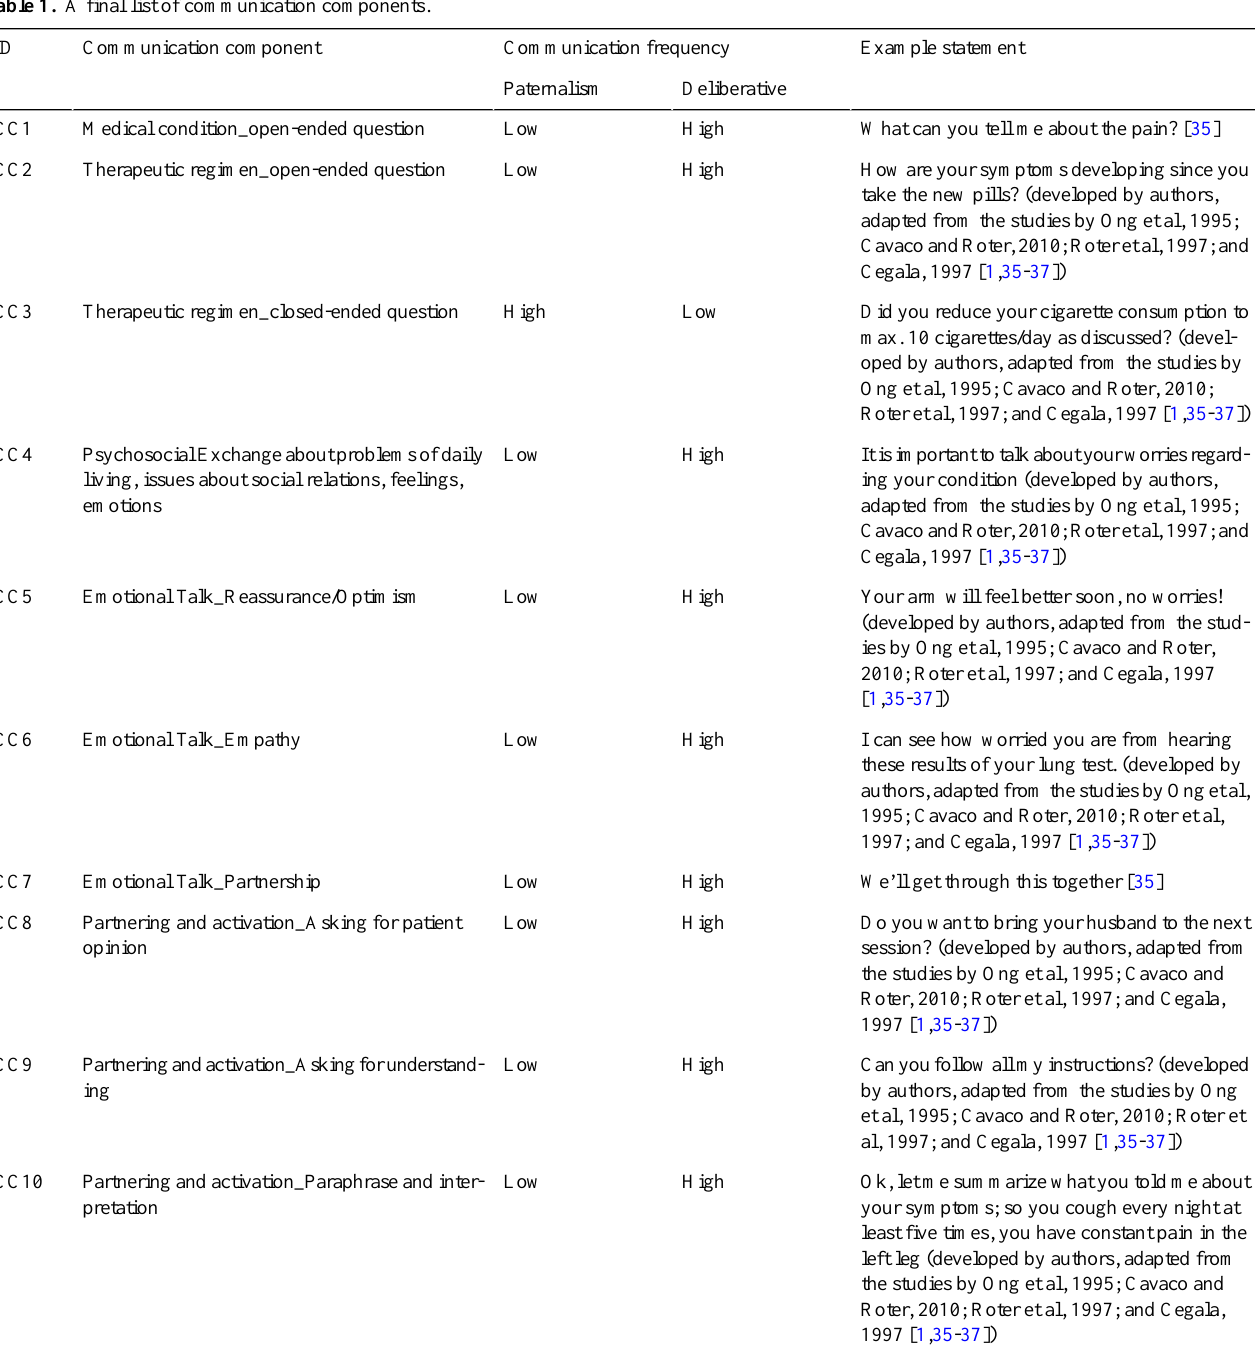
Table 1. A final list of communication